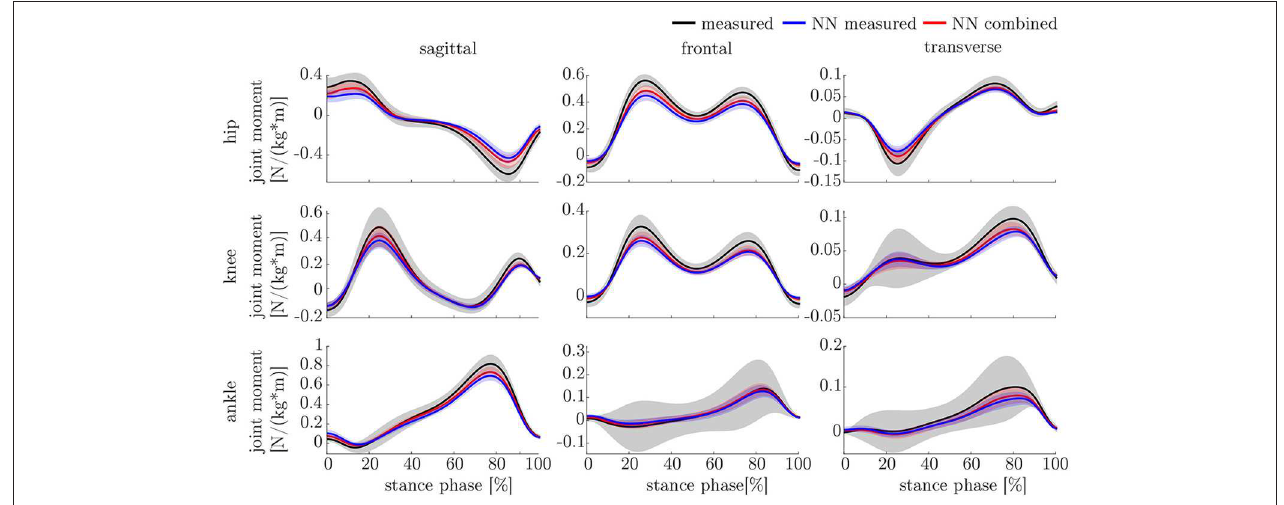
analyze the sensitivity of inputs and outputs (Ardestani et al.,